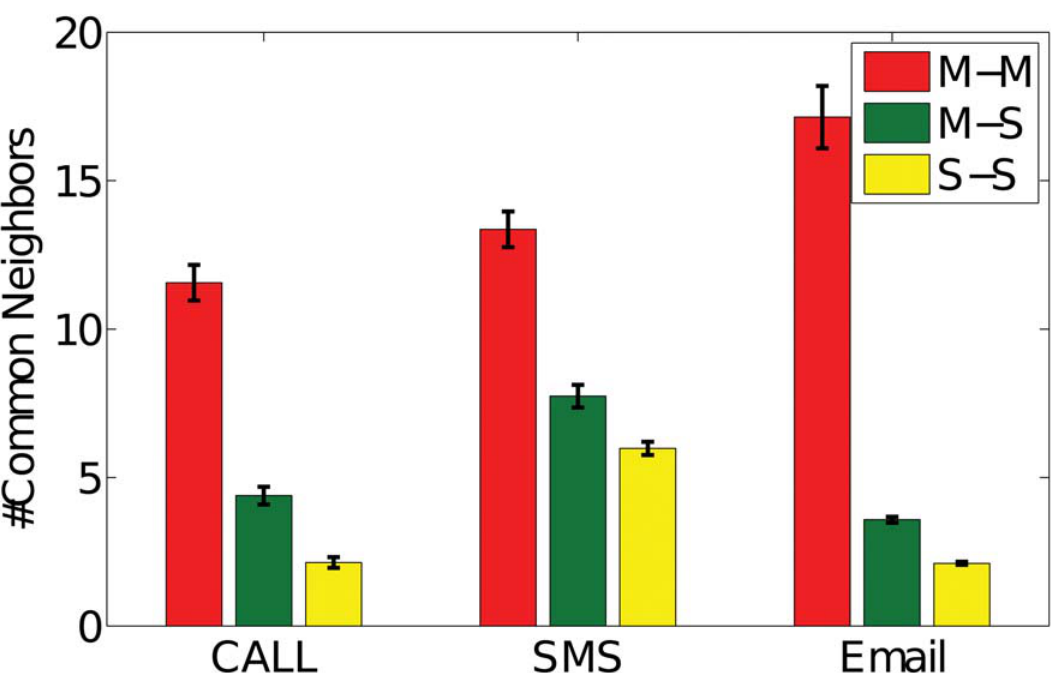
Fig 2. Homophily vs. Social Status. The number of common friends of each pair of employees are considered as the measurement of link homophily in social network, thus generating three different types of ties: M-M, M-S, S-S. Error bars show the confidence interval with significance level α =